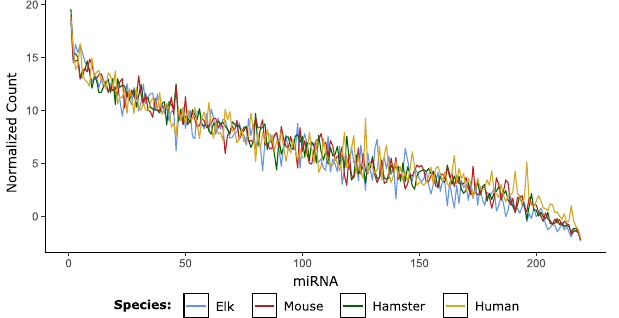
Figure 5. Serum miRNA abundance is conserved between elk, hamsters, mice and humans. The mean log2 transformed normalized read count was plotted for 219 miRNAs commonly detected in elk, hamster, mouse and human